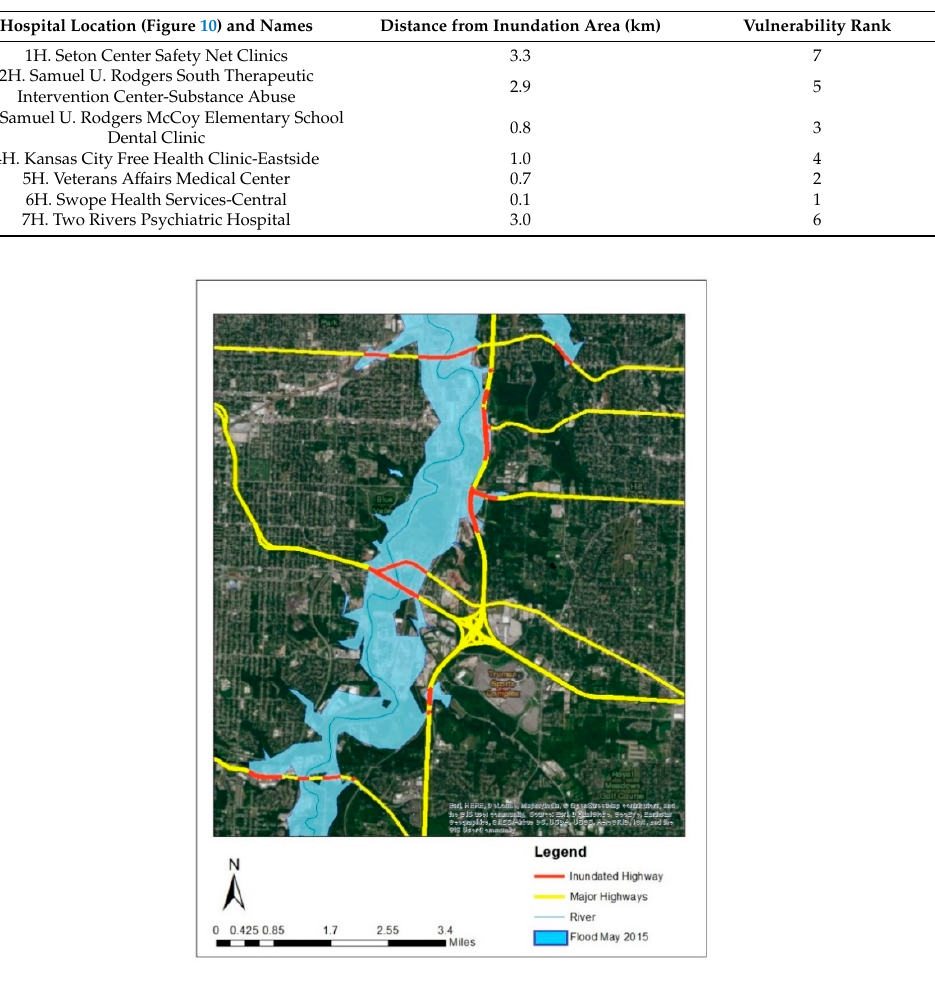
Figure 10. Location of major transportation routes under inundation due to the flood of May 2015.